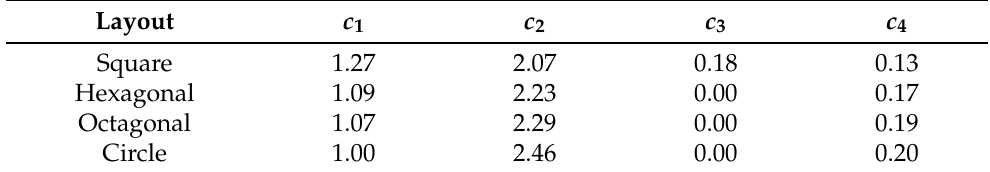
Table 2. Coefficients for Current Sheet Approximation Formula.